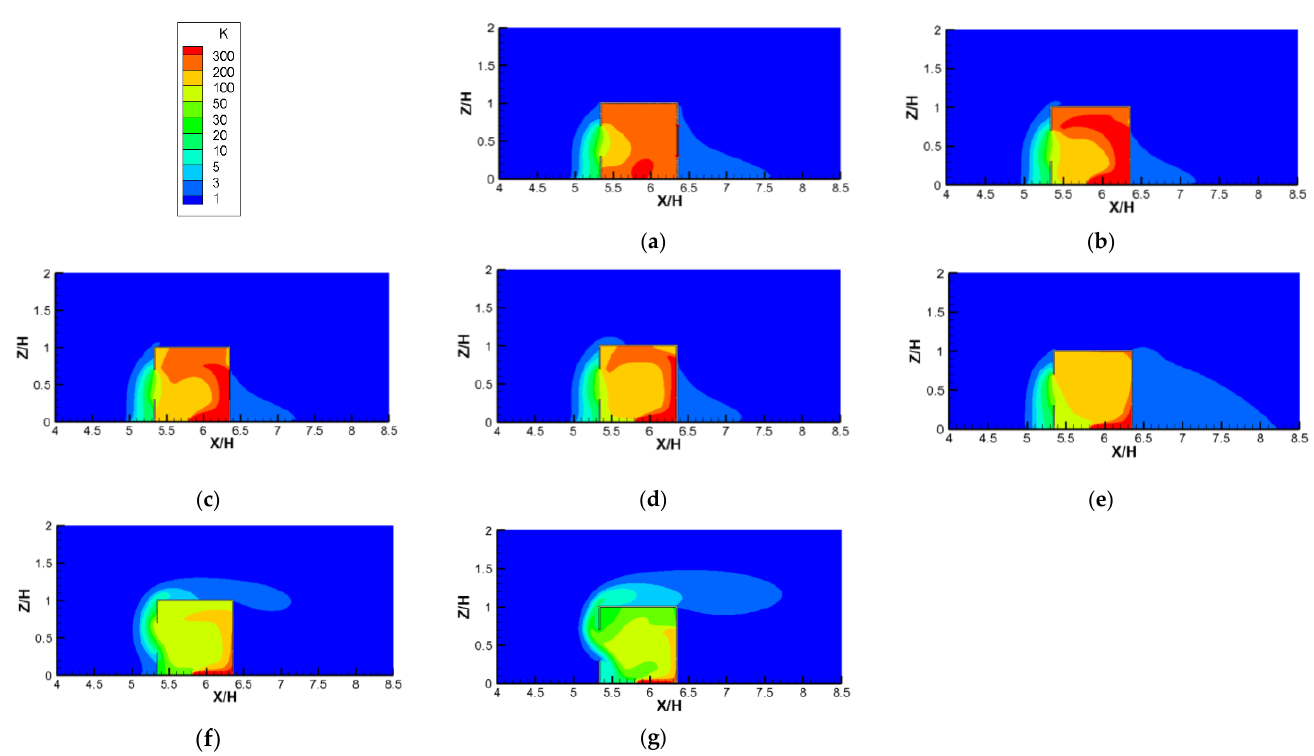
Figure 15. Contours of the dimensionless concentration (K) against increasing Ri values for single- sided ventilation cases. ( a ) Ri = 0; ( b ) Ri = 0.04; ( c ) Ri = 0.27; ( d ) Ri = 1.86; ( e ) Ri = 5.31; ( f ) Ri = 11.11; ( g ) Ri = 26.65.